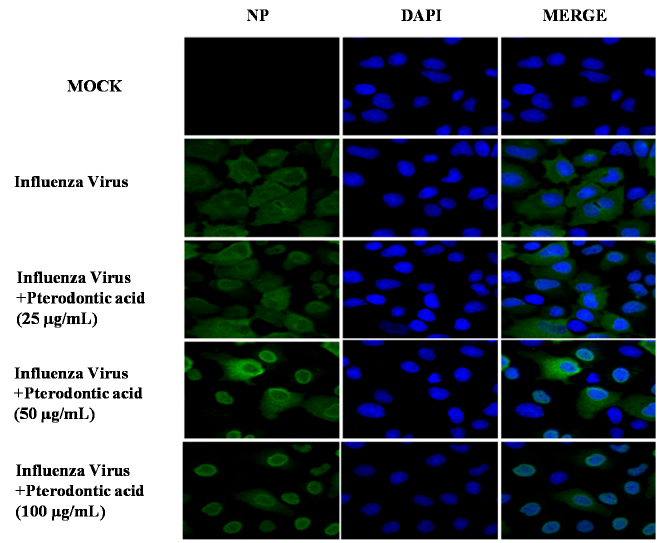
Figure 5. Pterodontic acid inhibited nuclear export of viral RNP. A549 cells infected with A/PR/8/34 (H1N1) virus (MOI = 0.1) in the absence or presence of different concentration of pterodontic acid for 8 h. The cells were stained with anti-viral nuclear protein antibody labeled with fluorescent monomer (green).The nucleus was stained with DAPI (blue).